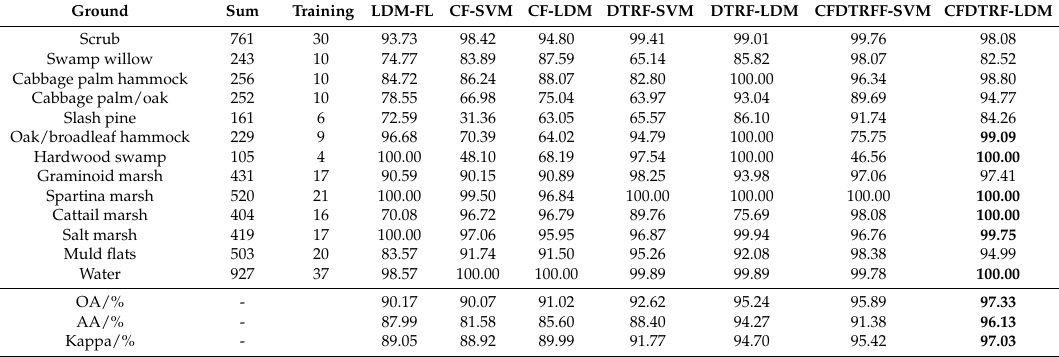
Table 6. Comparison of classification accuracies (in percent) provided by seven methods for Kennedy Space Center (part